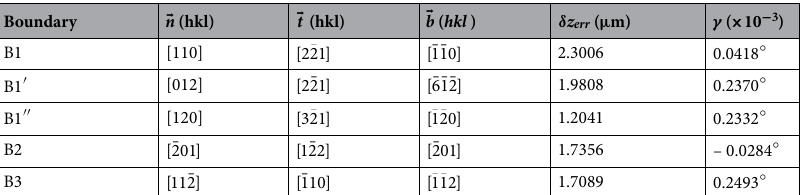
Table 1. Summary of the fitted boundary plane normal vectors ( (cid:31) n ), the calculated Burgers vectors ( (cid:31) b ), and the measured dislocation line vectors ( (cid:31) t ) for each boundary plane, denoted with the same labels from Fig. 4. The mean error ( δ z err ) from the plane fitting is also given. γ is the average misorientation angle ( �φ ) measured across the boundary (extracted from the measured φ